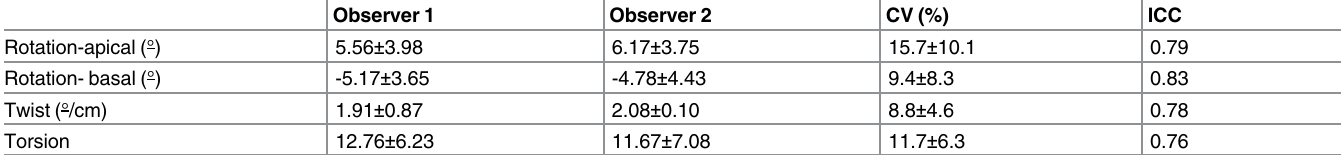
Table 7. Inter-observer variability of LV twist, torsion and rotation by